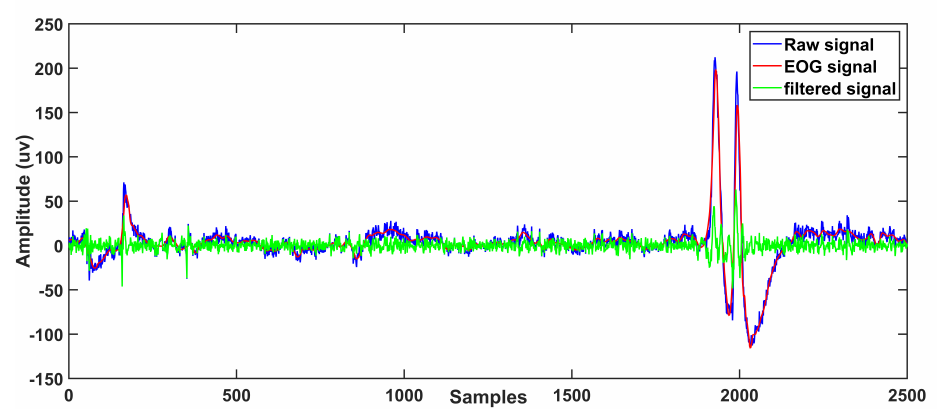
Figure 6. Decomposition of Raw EEG signal into IMFs using CiSSA.